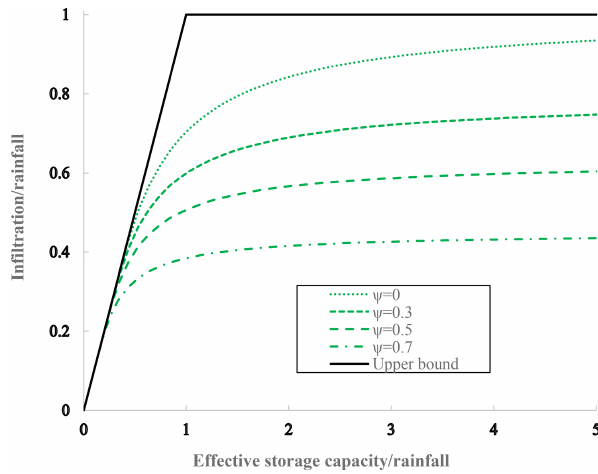
Figure 3. Modeling infiltration in the Budyko supply and demand framework: the ratio of infiltration (actual) and rainfall depth is a function of the ratio of infiltration capacity (demand) and rainfall depth (supply) as well as the initial soil moisture condition rep- resented by the degree of saturation ( ψ ) (reproduced from Wang,